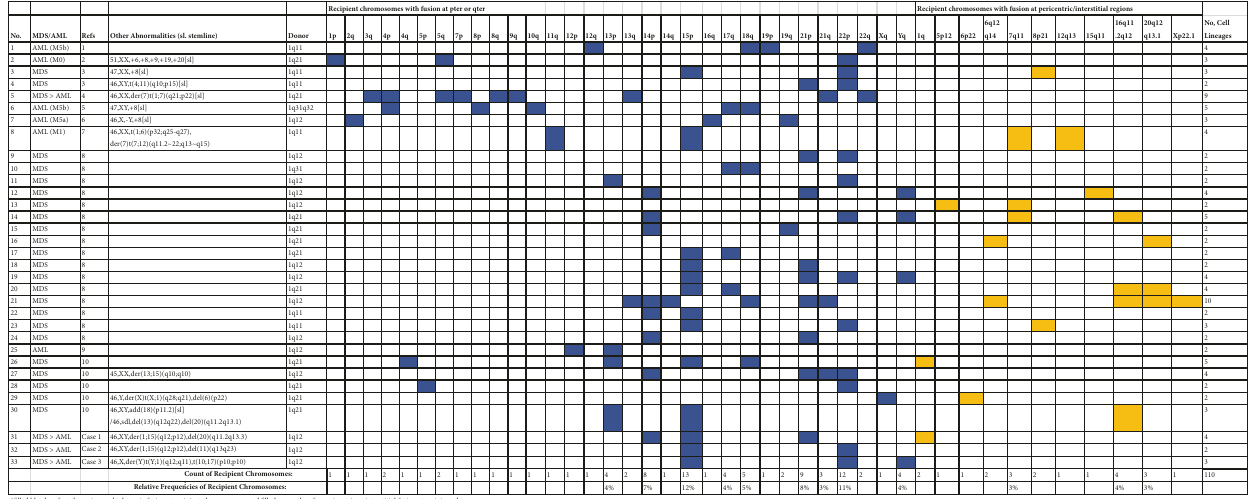
Figure 2: Patterns of donor and recipient chromosomes in jumping translocations of 1q of MDS and AML patients.